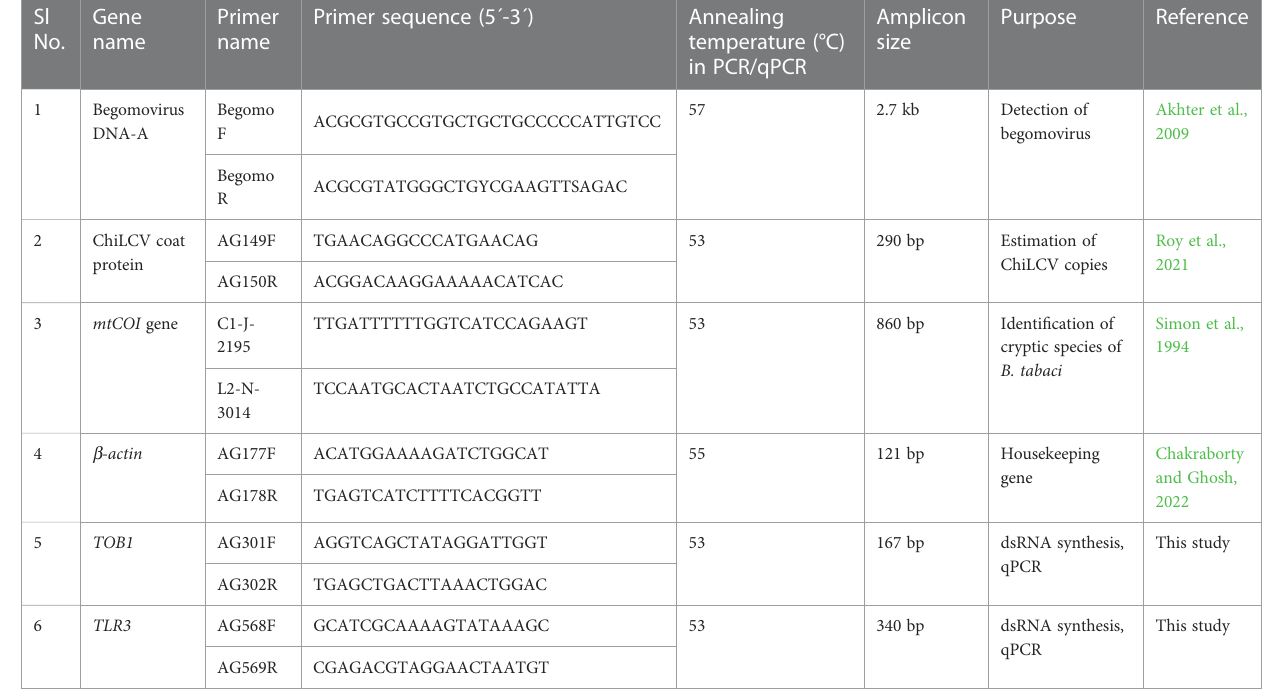
TABLE 1 List of primers used in the study. Sl